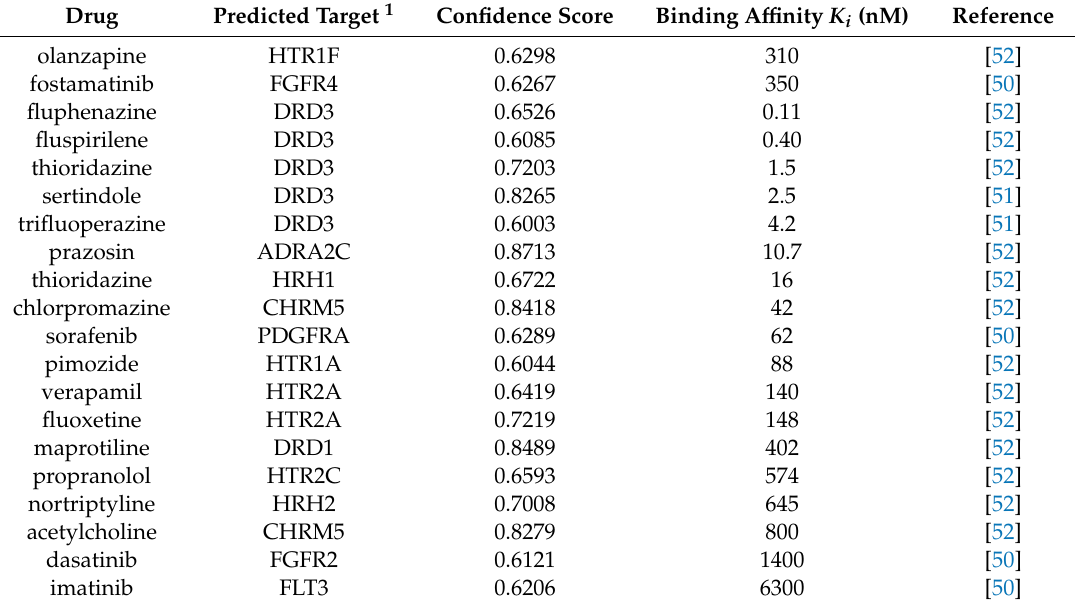
Table 1. Experimental validation of predicted drug–target